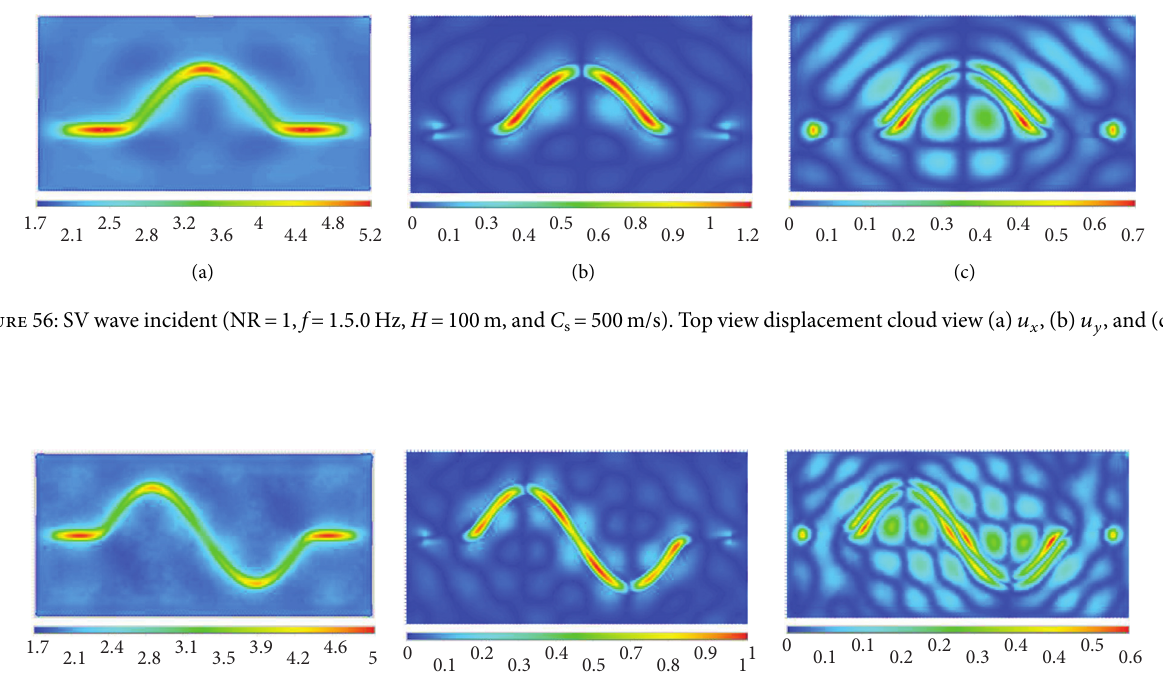
� 500m/s). Top view displacement cloud view (a) u s